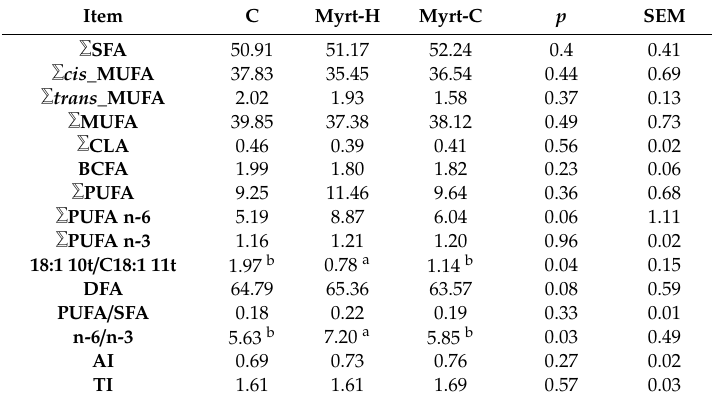
Table 4. Fatty acid groups (% of total FAME) and ratios of meat from ewes fed myrtle residues. Item C Myrt-H Myrt-C p SEM